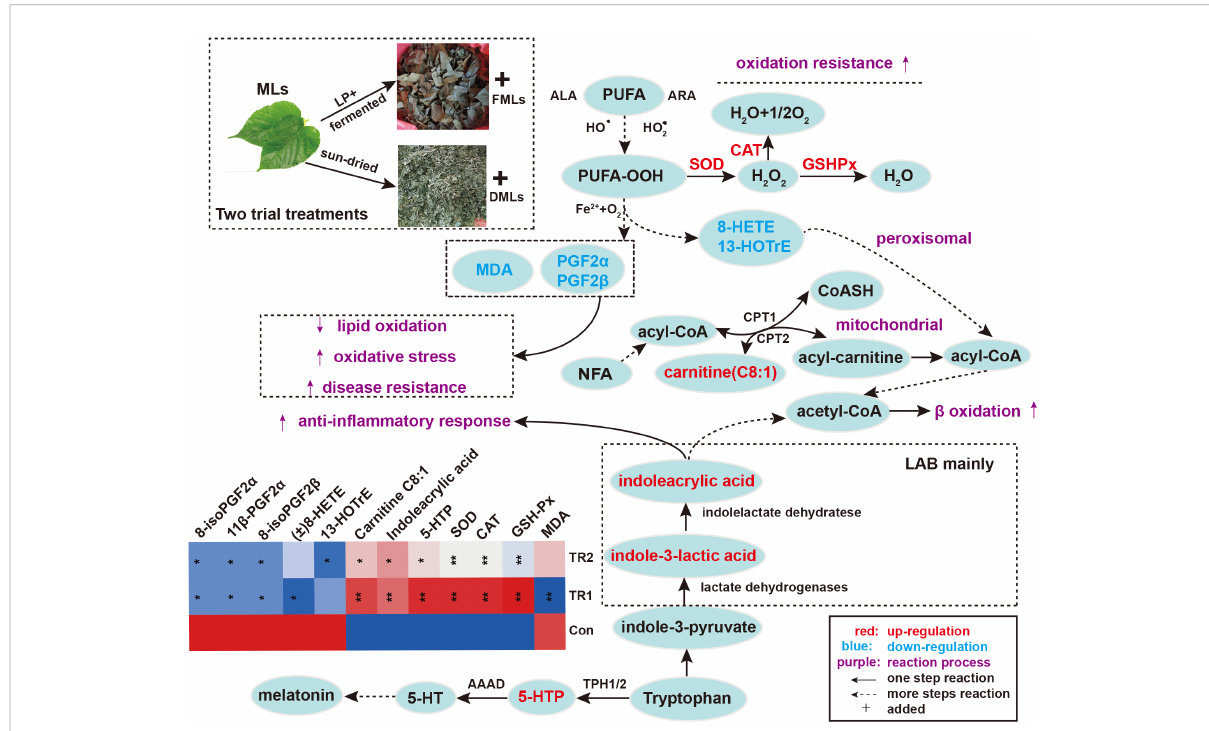
FIGURE 3 Peroxidation of PUFAs and tryptophan metabolism. Elevated metabolites are highlighted in red, reduced metabolites are shown in blue; the contents of painted green or red metabolites from top 20 DEMs and antioxidant biochemical indexes are displayed in heat map (* p <0.05, ** p <0.01, * and ** are TR1 or TR2 compared to Con). (MLs, mulberry leaves; FMLs, fermented mulberry leaves; DMLs, dried mulberry leaves; LP, Lactobacillus plantarum ; LAB, lactic acid bacteria; PUFA, polyunsaturated fatty acids; ALA, a linolenic acid; ARA, arachidonic Acid; CPT1/CPT2, carnitine palmitoyltransferase 1/2; NFA, medium-chain fatty acid; 5-HTP, 5-hydroxytryptophan; 5-HT, serotonin; AAAD, aromatic amino acid decarboxylase; TPH1/2, tryptophan hydroxylase